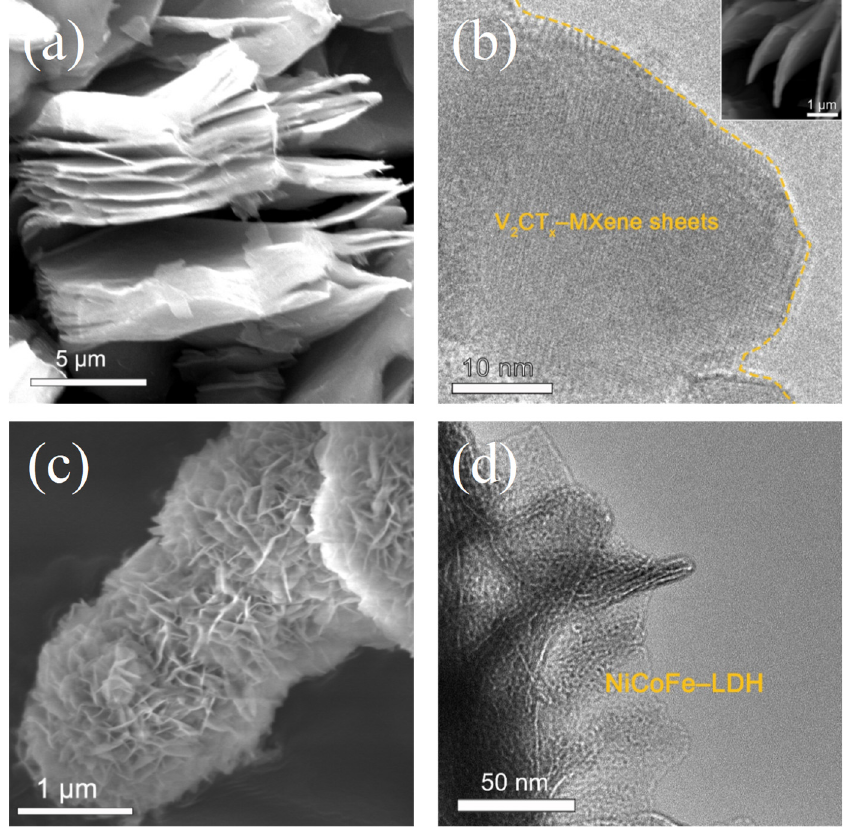
Figure 2. ( a ) Field emission SEM images of delaminated V 2 CT x –MXene sheets. ( b ) Field emission TEM images of few-layer V 2 CT x –MXene sheets. An SEM image is shown in the inset. ( c ) SEM and ( d ) TEM images of NiCoFe–LDH/V 2 CT x –MXene.